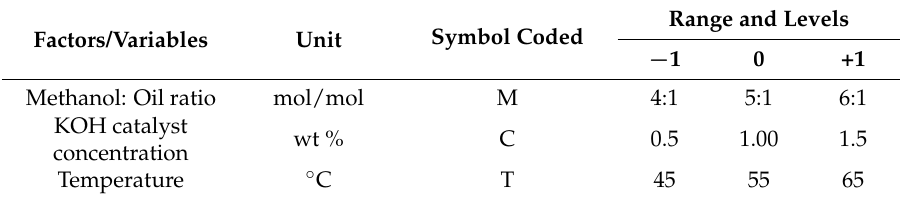
Table 1. Experimental range and levels coded for independent